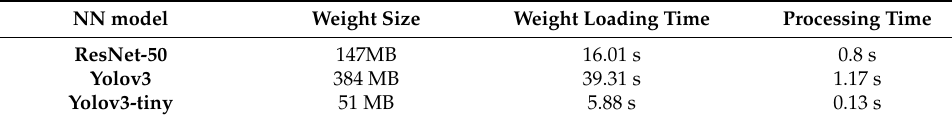
Table 4. NN engine speed for different NN models.